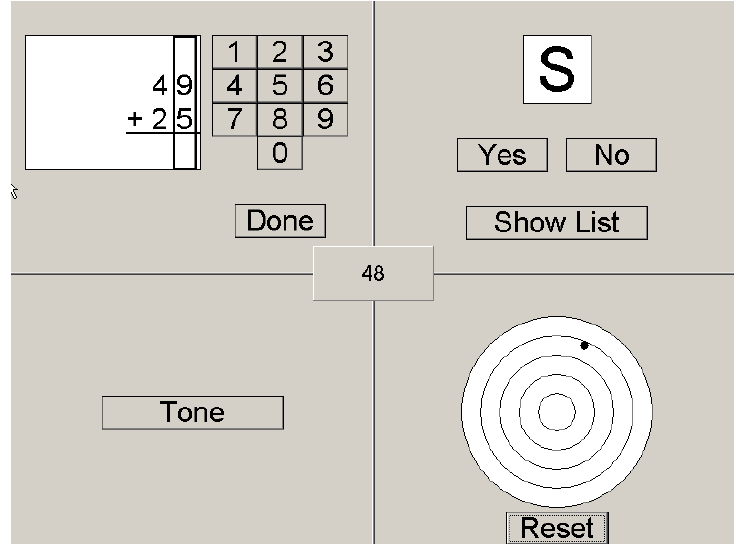
FIGURE 1. Example of the user interface of the computerized multitask. Top left, the arithmetic subtask; top right, the memory task; bottom left, the auditory attention task; bottom right, the visual vigilance